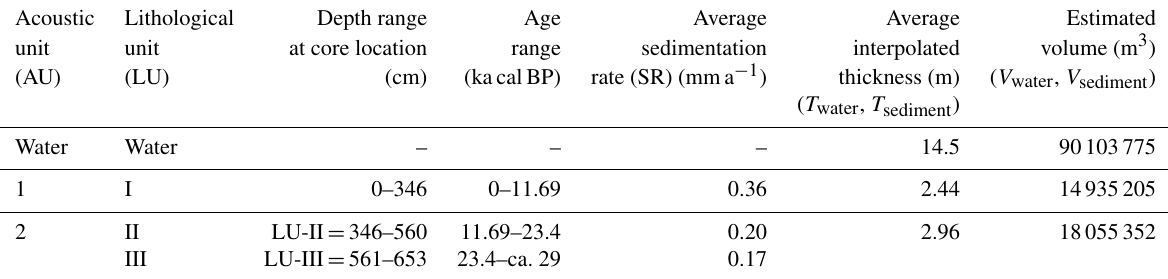
Table 2. Overview of general acoustic (AU) and lithological unit (LU) divisions with associated depth and age ranges and age-depth model calculated average sedimentation rates (SRs). Additionally shown are basin properties calculated using ArcMap 10.5.1 software including interpolated water and sediment thicknesses ( T water , T sediment ) and water and sediment package volumes ( V water , V sediment